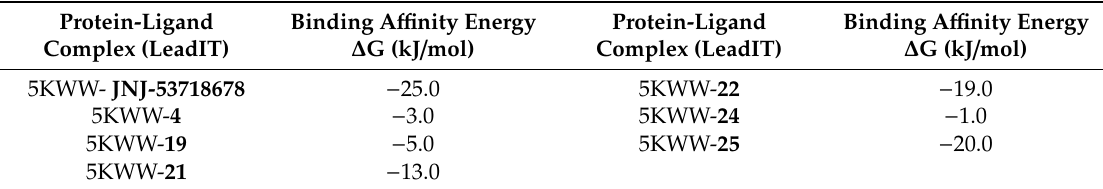
Table 3. Binding a ffi nity values obtained by molecular docking studies of the compounds JNJ-53718678 , 4 , 19 , 21 , 22 , 24 and 25 .